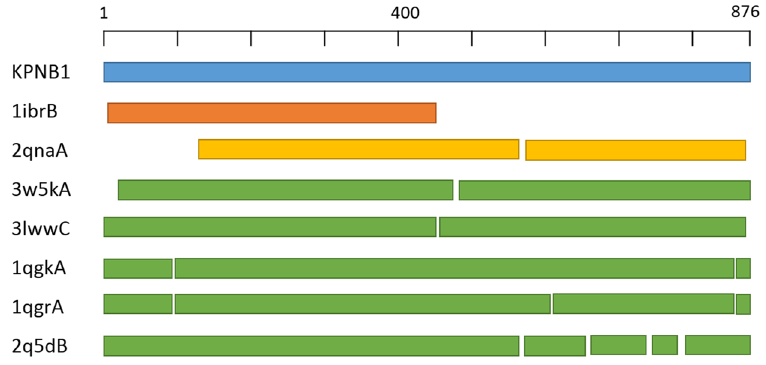
Figure 7. KPNB1 protein and its alternative conformations representative structures after clustering all PDB structures of it.